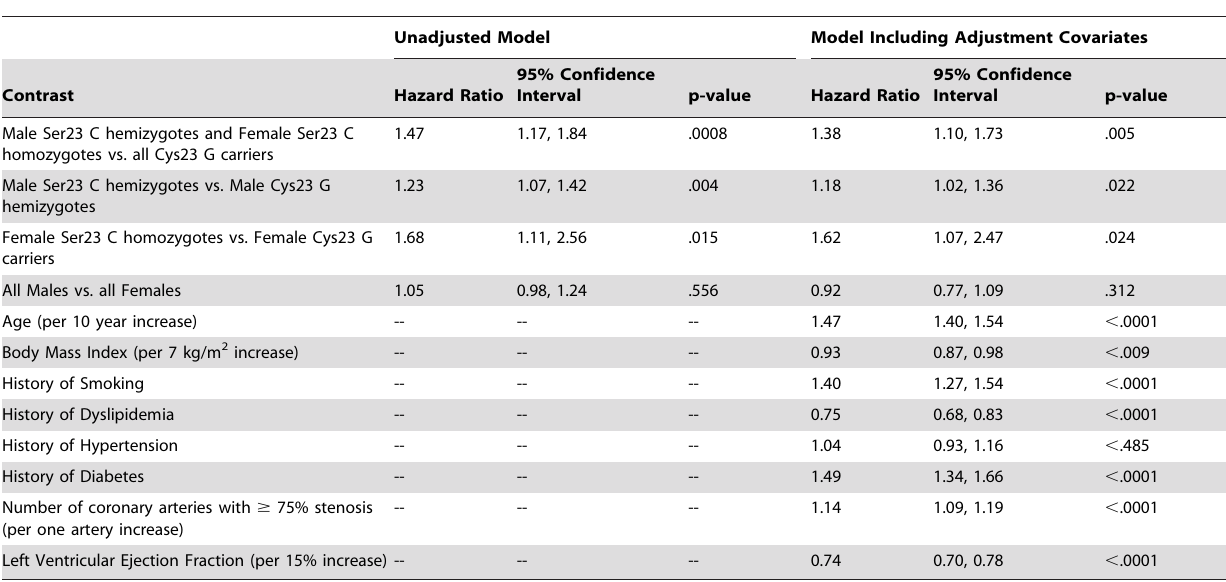
Table 2. Cox regression models predicting death or non-fatal myocardial infarction (N =6,126, N events =1,769).